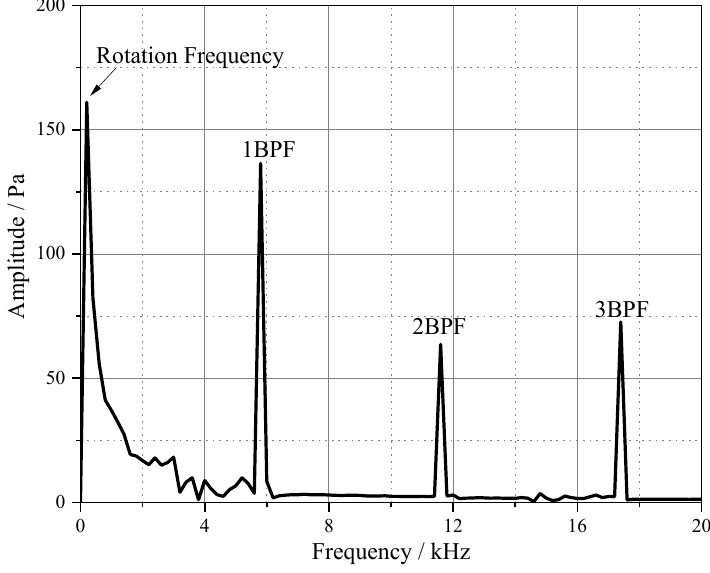
Figure 13. Pressure spectrum in front of LE under zero clearance model.